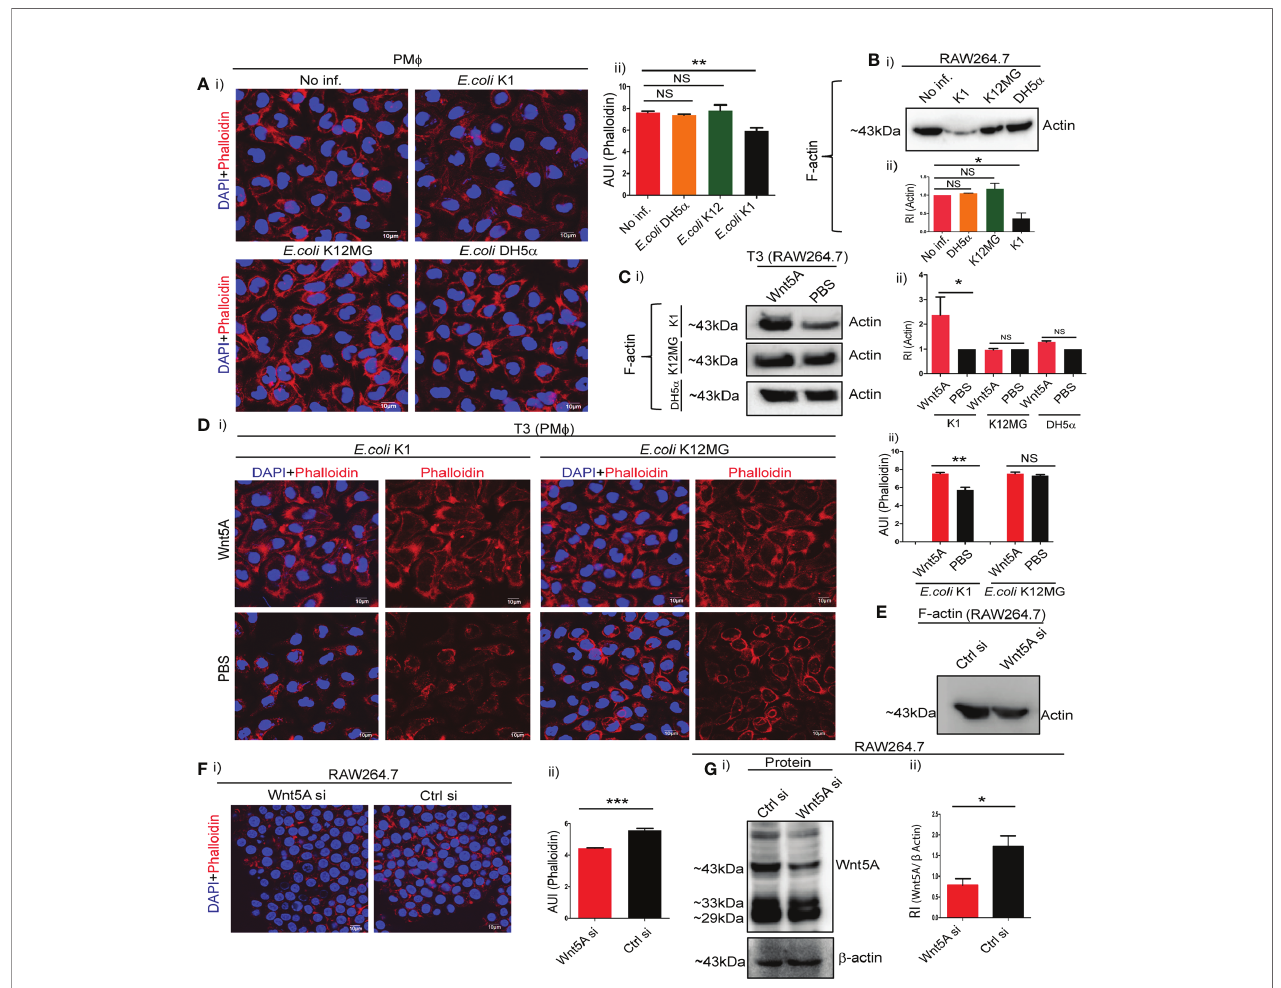
FIGURE 2 | Wnt5A signaling alters cytoskeletal actin assembly in relation to bacterial infection. Infection of PM f and RAW264.7 by pathogenic E. coli K1, but not non-pathogenic E. coli K12-MG1655 or E. coli DH5 a , at MOI:10 for 1 h resulted in decrease of total cellular F-actin as depicted by confocal microscopy of phalloidin stained cells (A : i, ii ) and immunoblotting of isolated F-actin (B : i, ii ) (n = 3). Phalloidin intensity (microscopy) and actin band intensity (immunoblotting) were measured by ImageJ and GelQuant (densitometry), respectively. Wnt5A signaling opposed effect of K1 infection (3 h incubation after 1 h infection: T3), enhancing F-actin formation as observed by immunoblotting (C: i, ii ) and confocal microscopy of phalloidin stained cells (D : i, ii ) (n = 3). Wnt5A signaling produced little or no change in F actin upon E. coli K12-MG1655 and E. coli DH5 a infection following similar procedure (C, D) . Decrease in endogenous Wnt5A level resulted in decrease of total cellular F-actin in RAW 264.7 as demonstrated by immunoblotting (E) and confocal microscopy (F : i, ii ) (n = 3). Depletion of Wnt5A expression by siRNA transfection was assessed through immunoblotting (G : i, ii ) . Data represented as mean ± SEM; * p ≤ 0.05, ** p ≤ 0.005, *** p ≤ 0.0005; NS, not signi fi cant. Phalloidin stain shown in red and DAPI (nuclear) stain shown in blue. AUI, arbitary unit of intensity; RI, relative